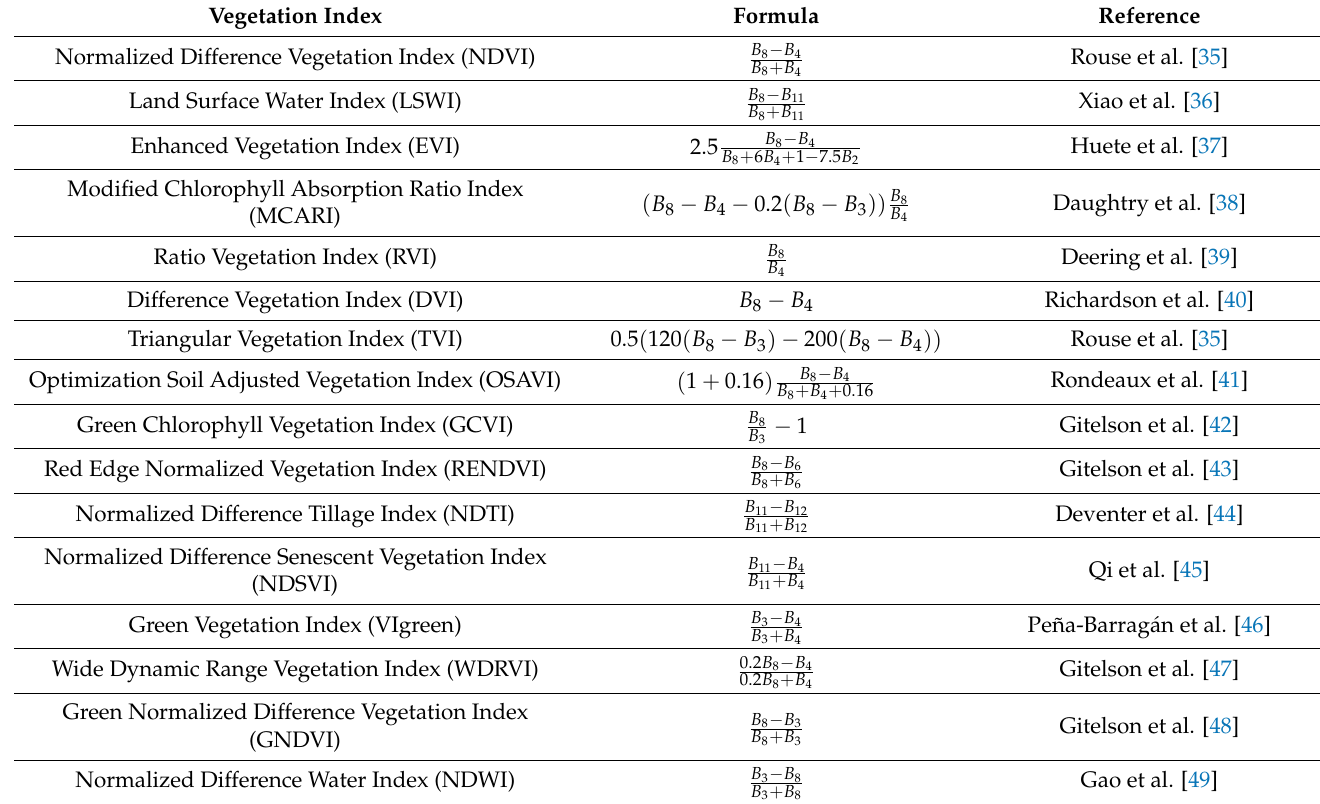
Table 4. Vegetation Index used in this